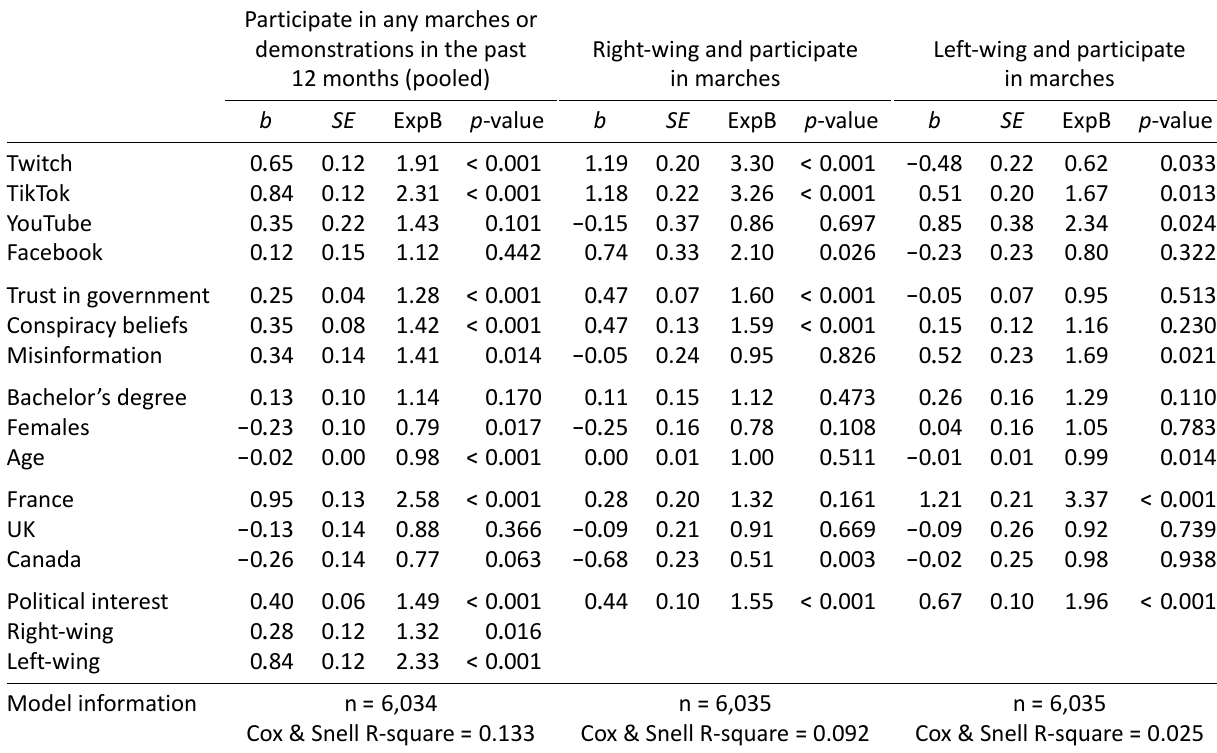
Table 3. Logistic regression of participation in marches or demonstrations. Participate in any marches